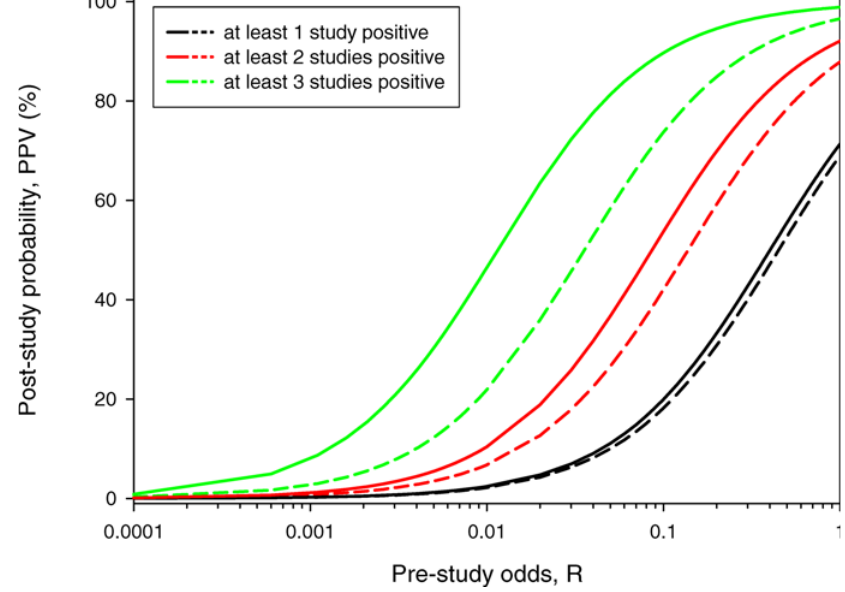
Figure 1. Probability of a True Relationship When At Least One, Two, or Three (Out of Ten) Studies Have Statistically Signifi cant Results as a Function of the Pre-Study Odds of a True Relationship (α = 0.05) Dashed lines refer to power of 0.2 and solid lines to power of